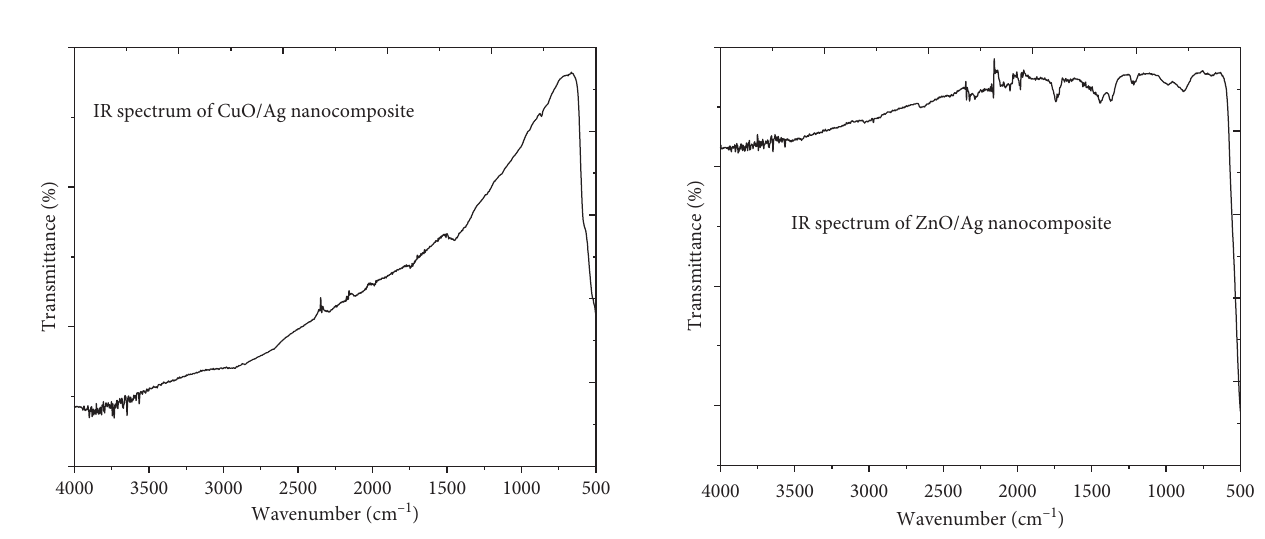
10: FTIR spectra analysis of ZnO/Ag nanocomposite.